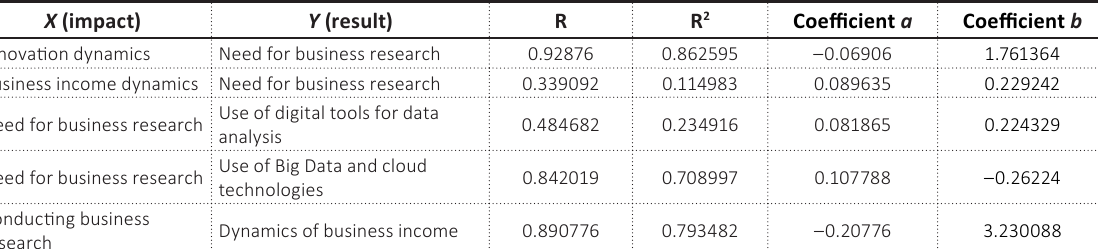
Table 7. Regression analysis